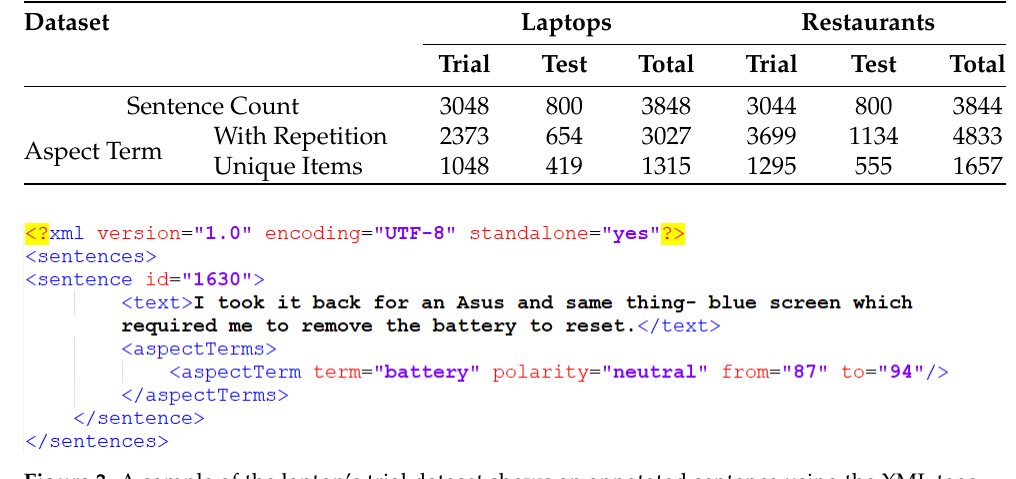
Figure 3. A sample of the laptop’s trial dataset shows an annotated sentence using the XML